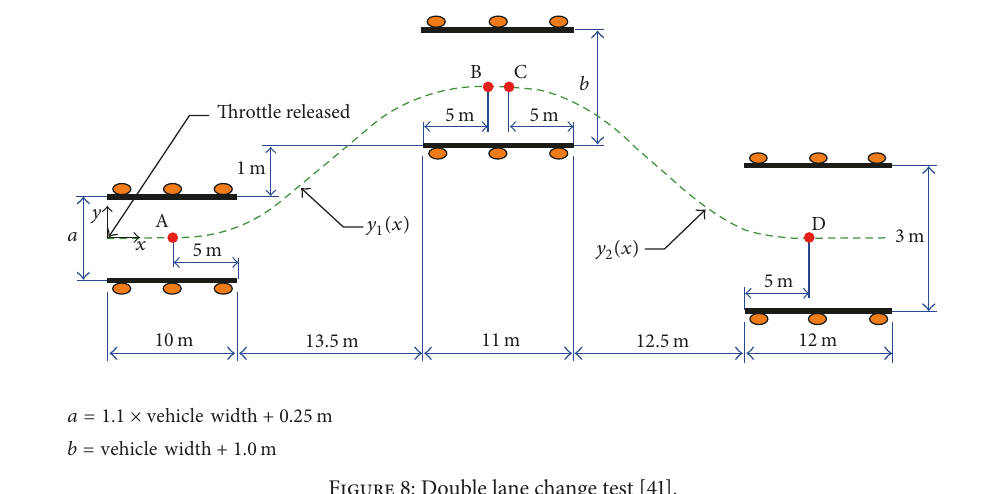
Figure 7: Skid-pad test [40].